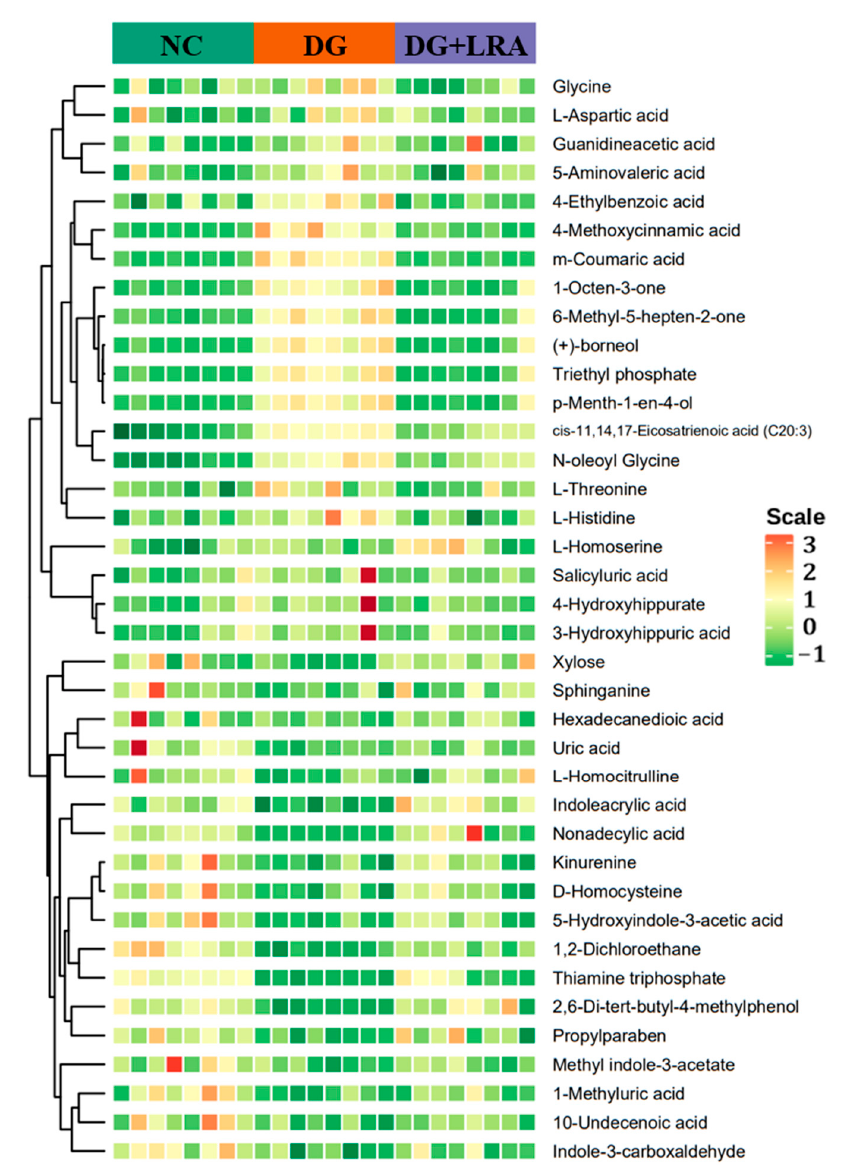
Figure 3. Cluster heat map of differential metabolites.